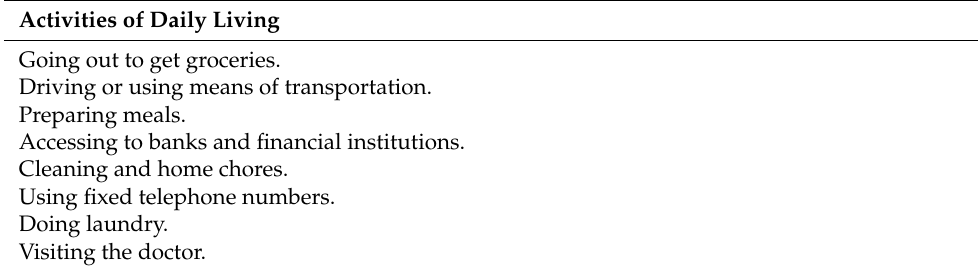
Table 1. Considerations included in Activities of Daily